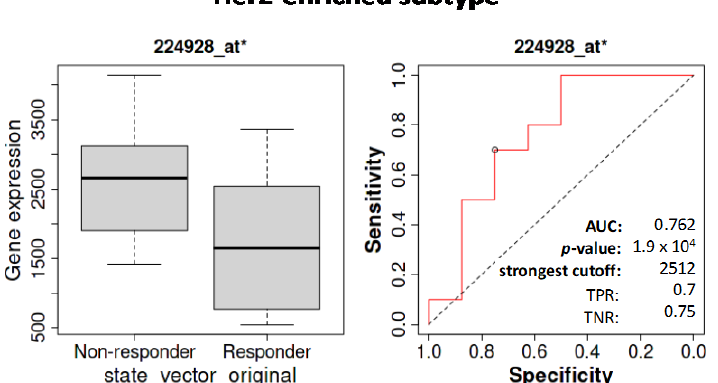
Figure 7. ROCplotter analysis to study the correlation between SETD7 mRNA expression (microarray data) and 5-year RFS for patients receiving any anti-Her2 therapy (29 responders and 21 non-responders). AUC—area under the curve; TNR—true-negative rate; TPR—true-positive rate.